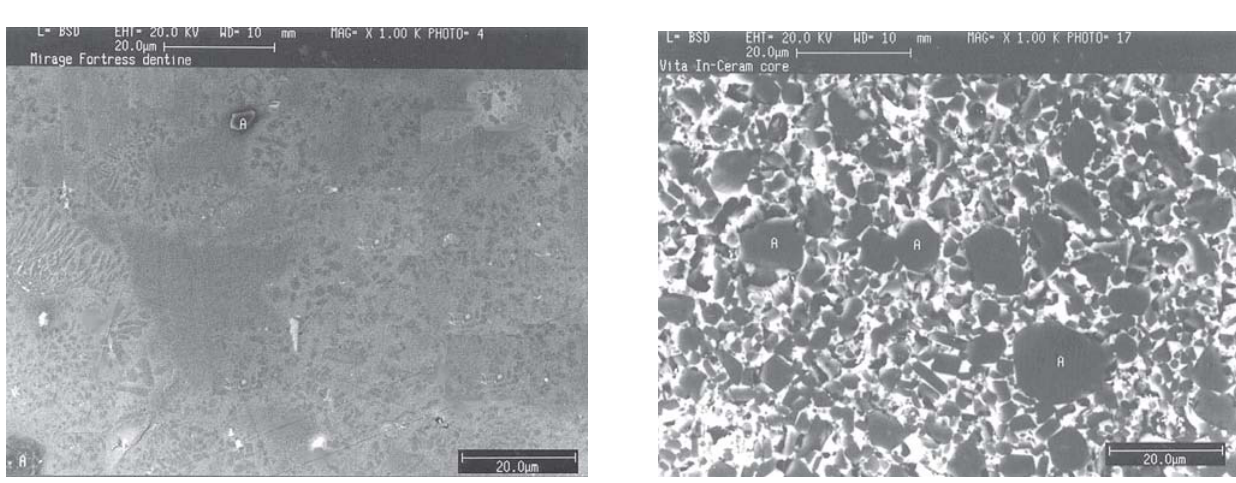
O ) particles (dark) 2 3